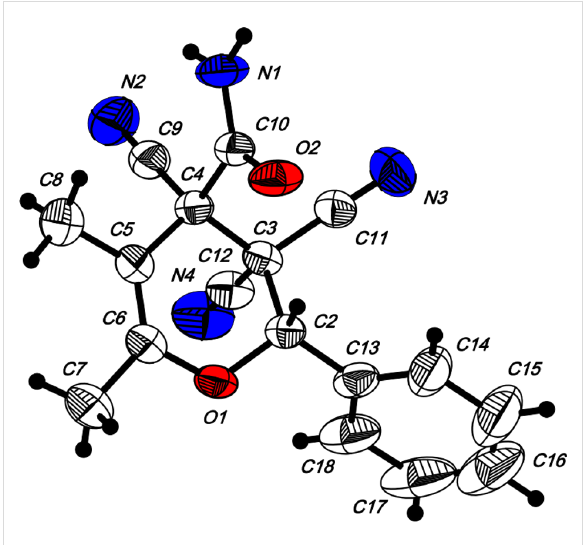
Figure 1: The molecular structure of 2a with atom-numbering scheme. Displacement ellipsoids are drawn at the 50% probability level and H atoms are drawn as small spheres of arbitrary